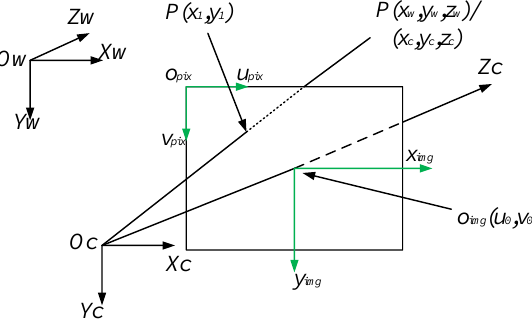
Figure 3. Geometric model of the camera imaging system.